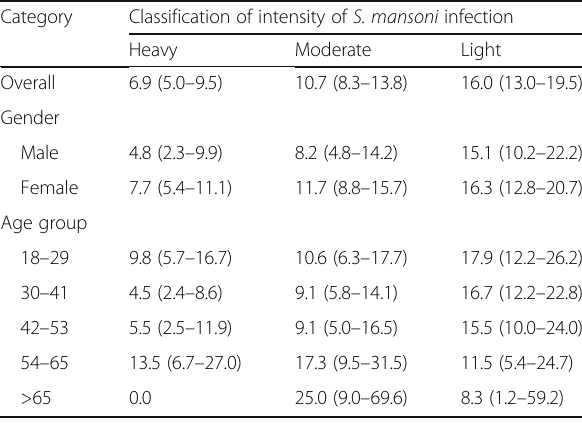
Table 2 Prevalence (%) of light, moderate and heavy intensity of S. mansoni